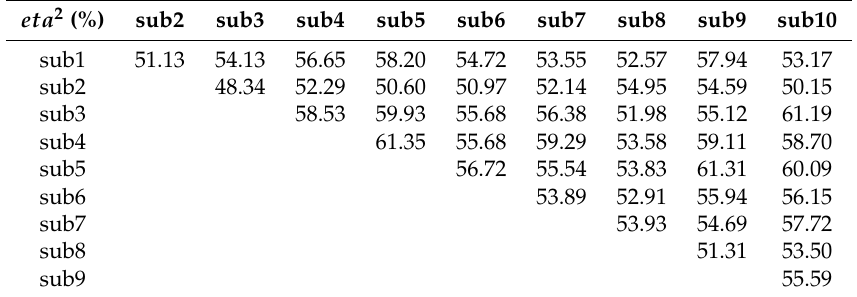
Table A3. The eta 2 similarity for the core-periphery structure among the first 10 subjects of the HCP resting-state dataset.